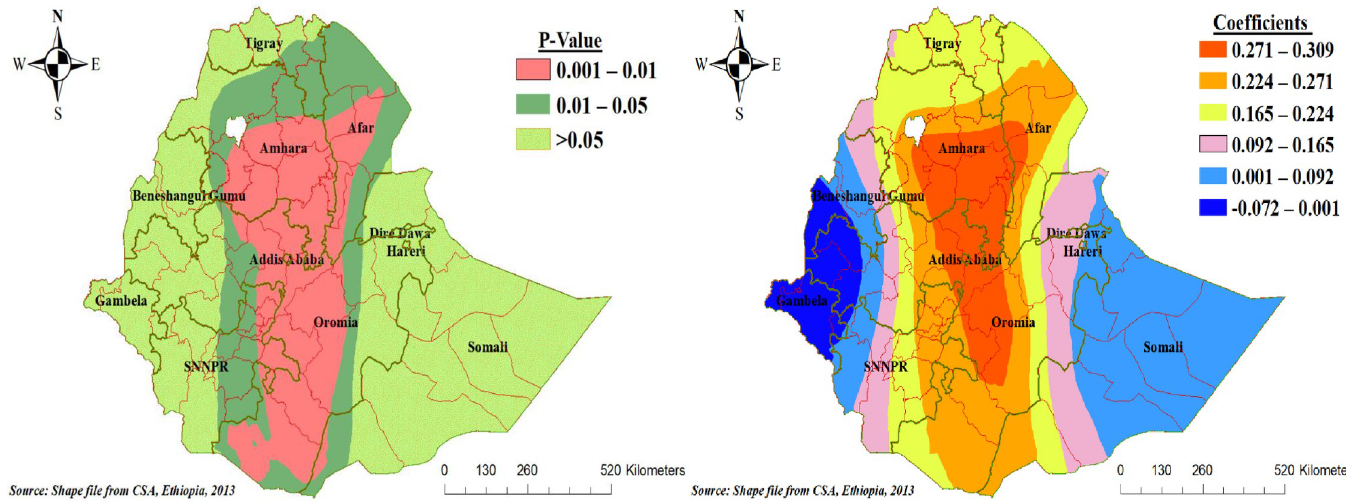
Fig 6. Geographically varying values of significance and coefficients per cluster for the independent variable rural residence of poor consumption foods rich in vitamin A in the final GWR model.